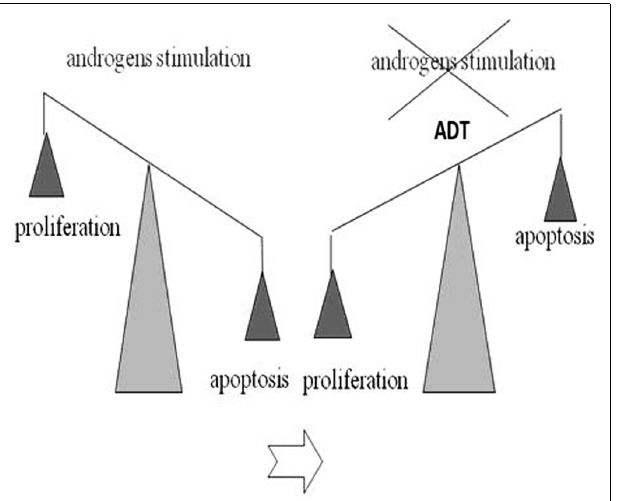
FIGURE 2 |Androgen-deprivation therapy (ADT) effect on proliferation/ apoptosis PC cells: androgens stimulate the tumor cells proliferation and inhibit their apoptosis. ADT reverses the equilibrium in favor of the apoptosis.